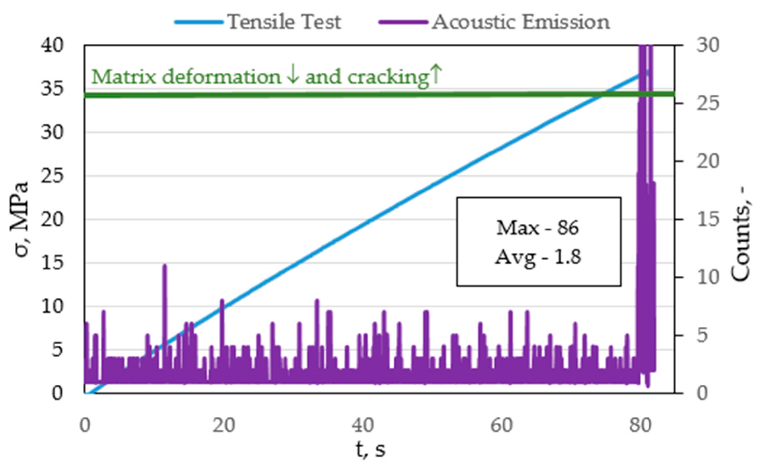
Figure 11. Graph of the counts plotted on the graph of tensile versus time for a selected sample based on pure polyester resin.